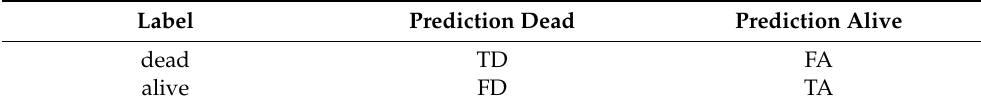
Table 4. Confusion matrix for our